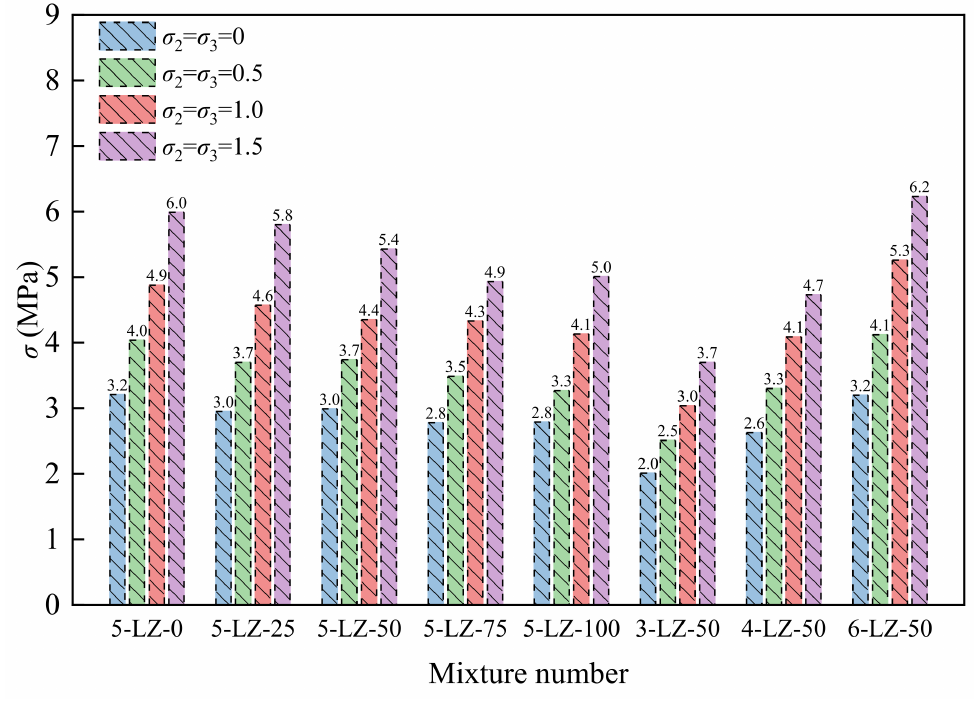
Figure 11. Peak stress of specimens under different confining